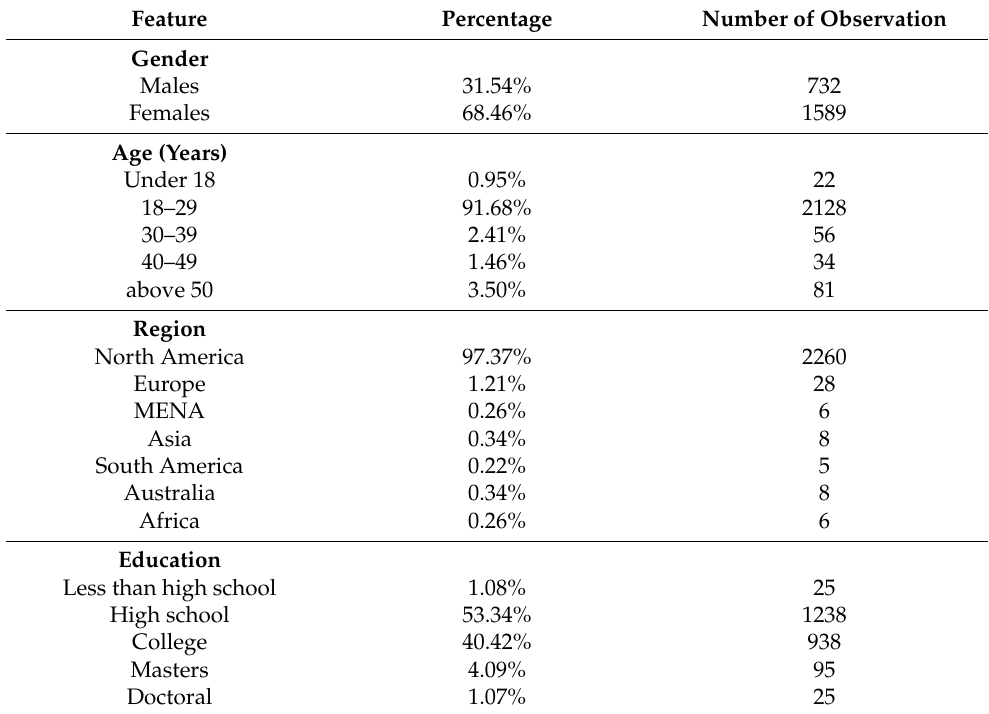
Table 1. Descriptive statistics of demographic features (N =